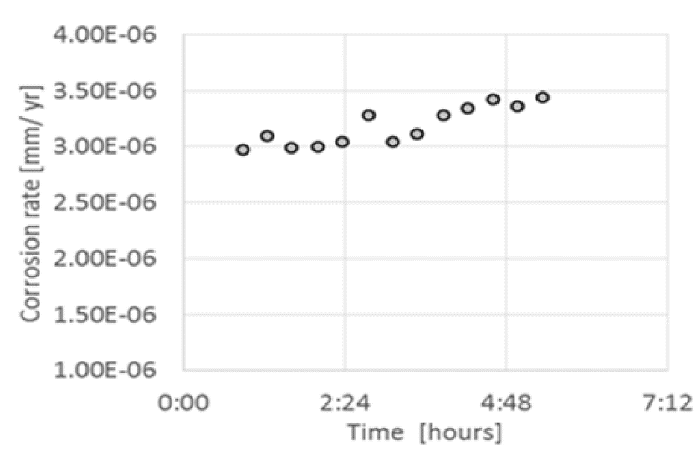
Figure 1. The corrosion rate of a carbon steel wire overtime via linear polarization resistance (LPR) on day 3 at 60 °C using the modified commercial cell. Reproduced with permission from ref. [68].